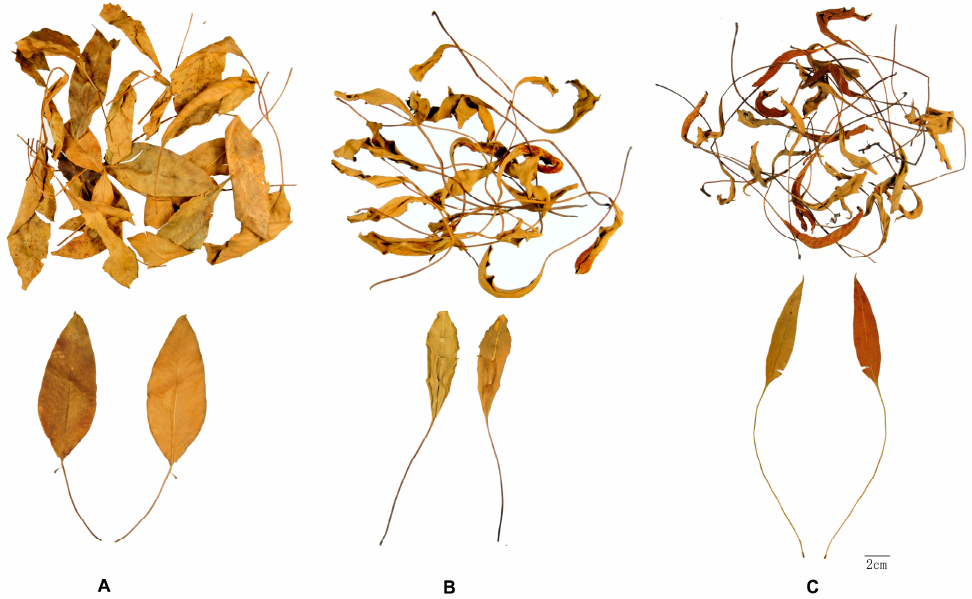
Figure 1. Photograph of Pyrrosiae Folium ( A ) Pyrrosia sheareri ; ( B ) P. lingua ; ( C ) P. petiolosa . (Upper: whole herb, Lower: unfolded leaf).